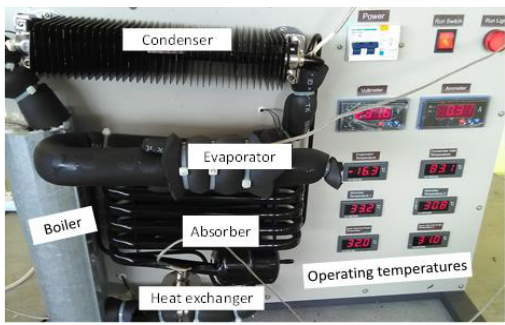
Figure 6: Experimental absorption refrigeration system